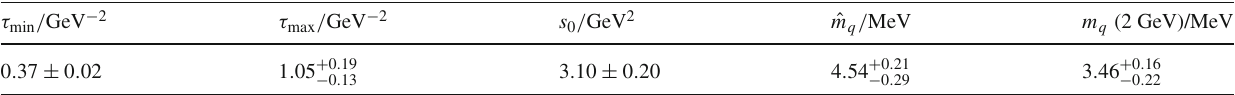
Table 1 Results from the SVZ QCD sum rules. The uncertainties of the Borel windows τ min , max , s 0 and ˆ m q are obtained by taking into account the error bars of the OPE parameters in Eq. (27) and κ = 3 . 0 ± 1 .